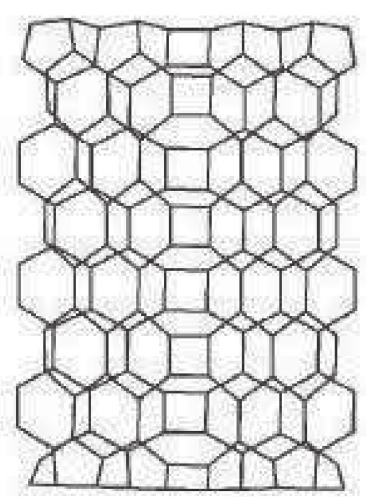
Figure 7: Graph of NPHX [ x,y ] .